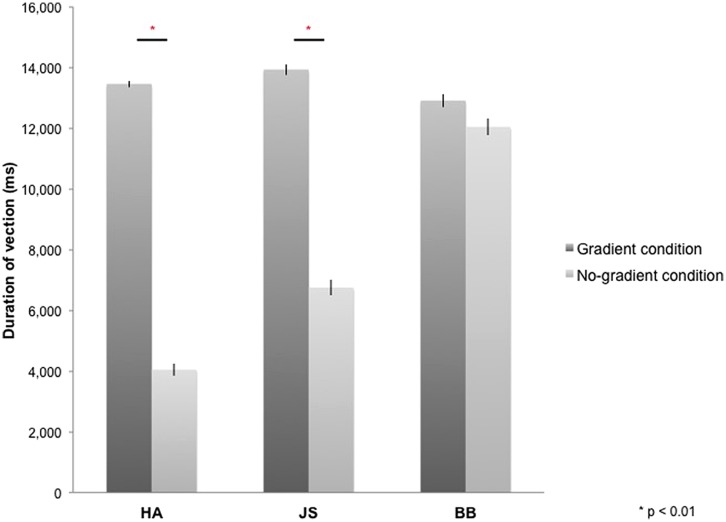
Duration of vection perceived during 16-s stimulus blocks in gradient and no-gradient conditions averaged over 10 runs for each participant. Error bars indicate SE.